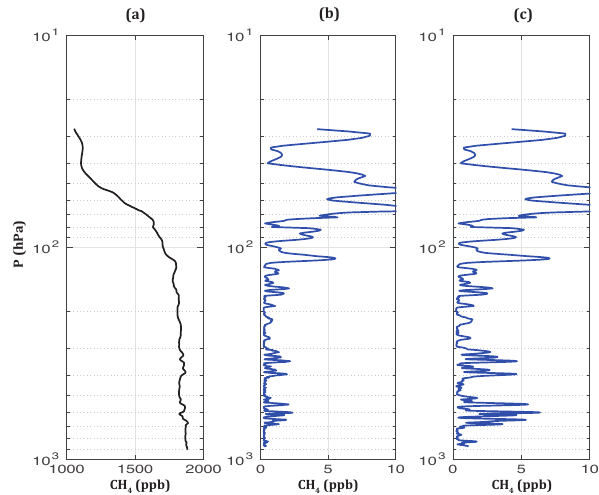
Figure 11. (a) AirCore-HR CH 4 vertical profile, (b) CH 4 uncer- tainty without taking the potential loss of air into account (see Sect. 4.2, point v) and (c) overall CH 4